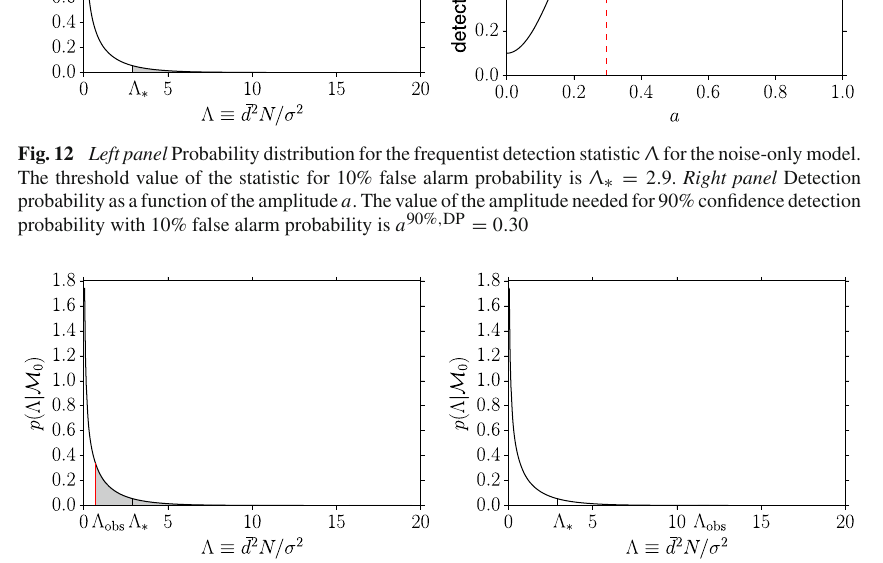
Fig.13 Graphicalrepresentationofthe p -valuecalculationfortheweak( leftpanel )andstrong( rightpanel ) injections. For the weak injection, Λ obs = 0 . 72 is marked by the red vertical line , with corresponding p - value 0 . 45. For the strong injection, Λ obs = 11 . 2 is sufficiently large that the corresponding red vertical line is not visible on this graph. The p -value for the strong injection is 9 . 0 × 10 − 4